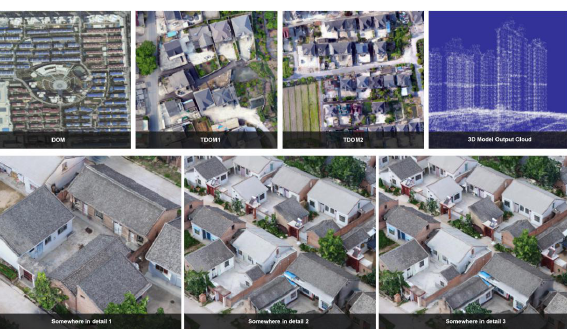
Fig.4 TIRAIN 3D Real-Scene Monitoring